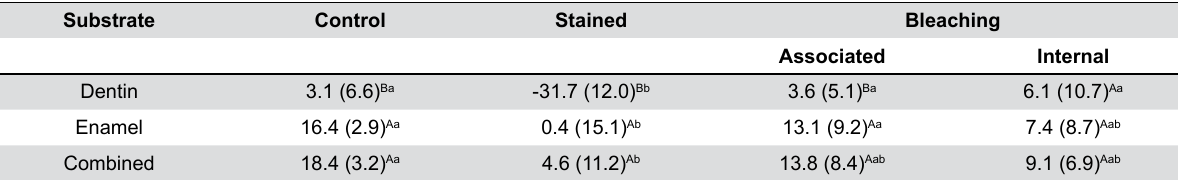
Table 2- Means (standard deviations) of WID according to substrate and bleaching technique (n =